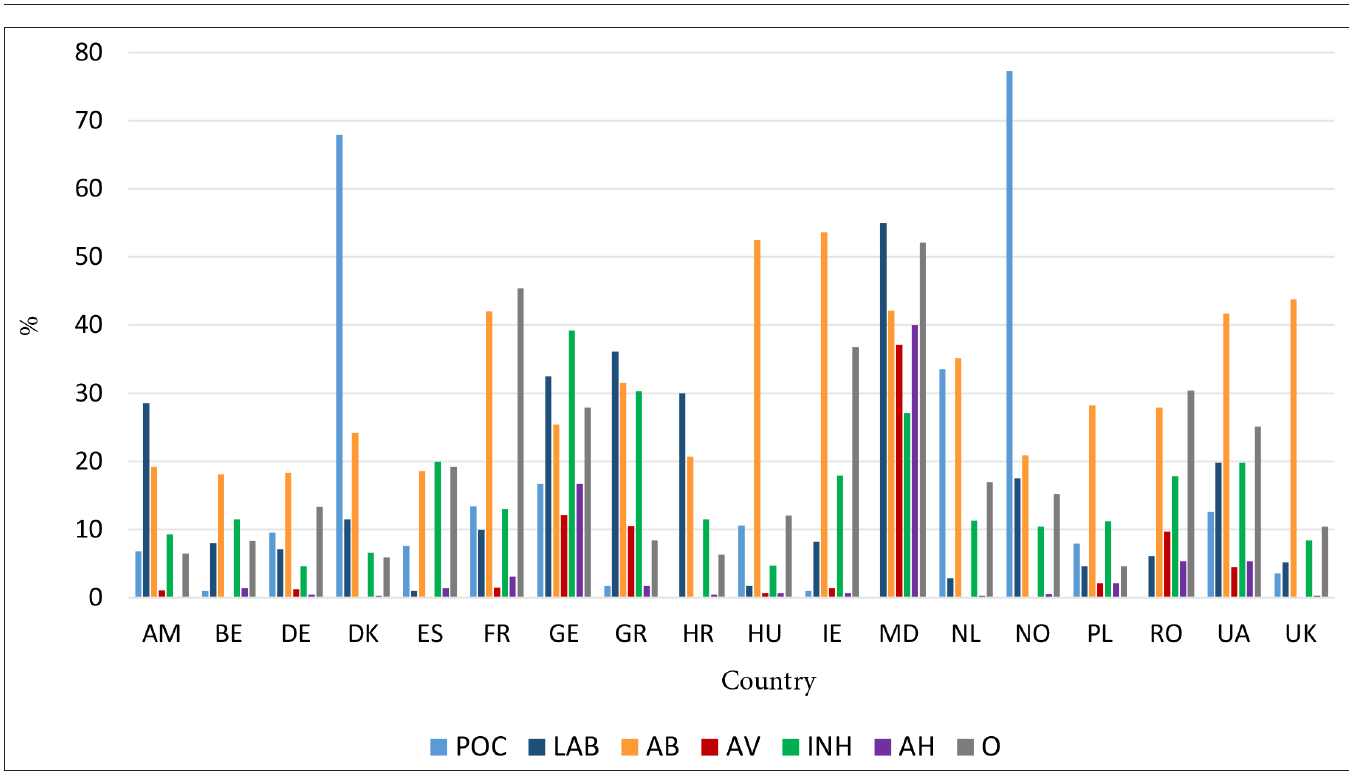
Figure 1 Country variation in point- of- care and laboratory or hospital- based diagnostic testing, and in medication prescribing for respiratory tract infection in primary care. AB = antibiotic. AH = antihistamine. AM = Armenia. AV = antiviral. BE = Belgium. DE = Germany. DK = Denmark. ES = Spain. FR = France. GE = Georgia. GR = Greece. HR = Croatia. HU = Hungary. IE = Ireland. INH = inhaled medication. LAB = laboratory or hospital- based. MD = Moldova. NL = the Netherlands. NO = Norway. O = other prescribed medication. PL = Poland. POC = point of care. UA = Ukraine. UK = United